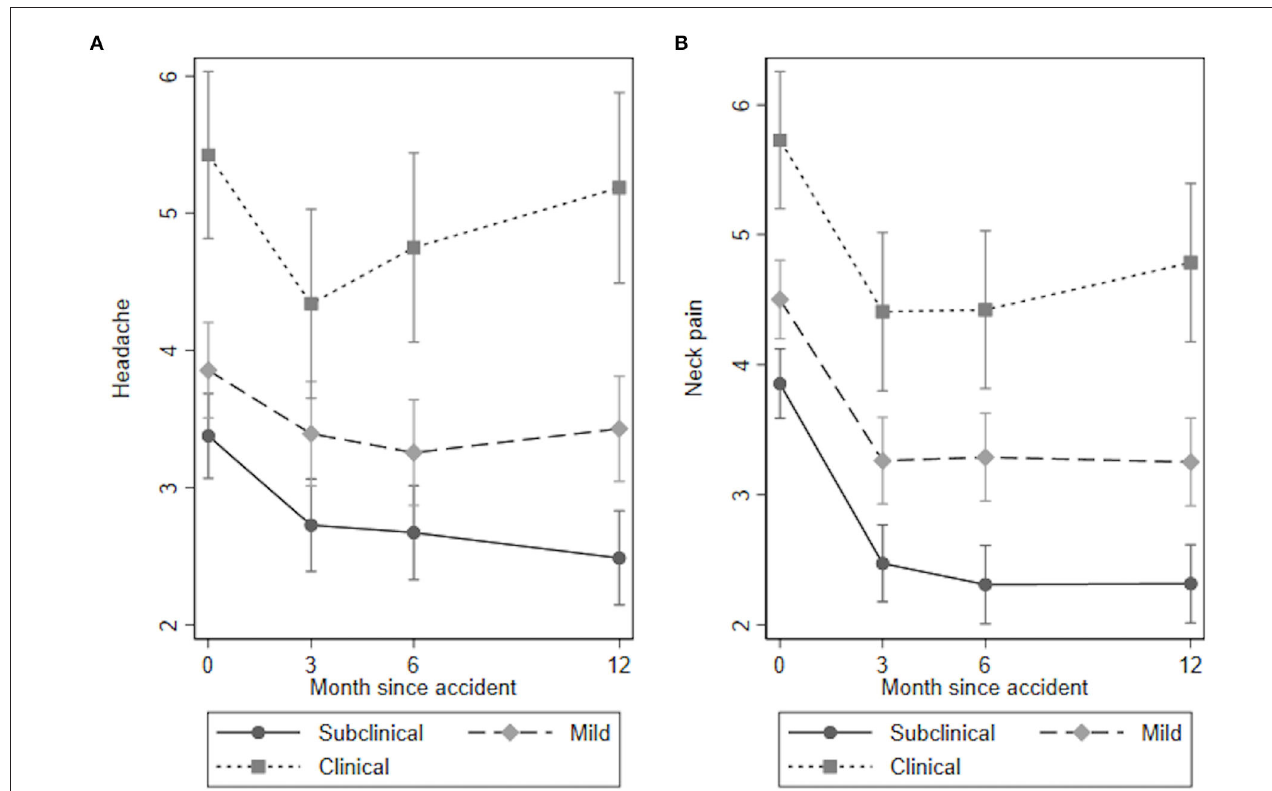
FIGURE 4 | (A) Headache and (B) Neck pain over